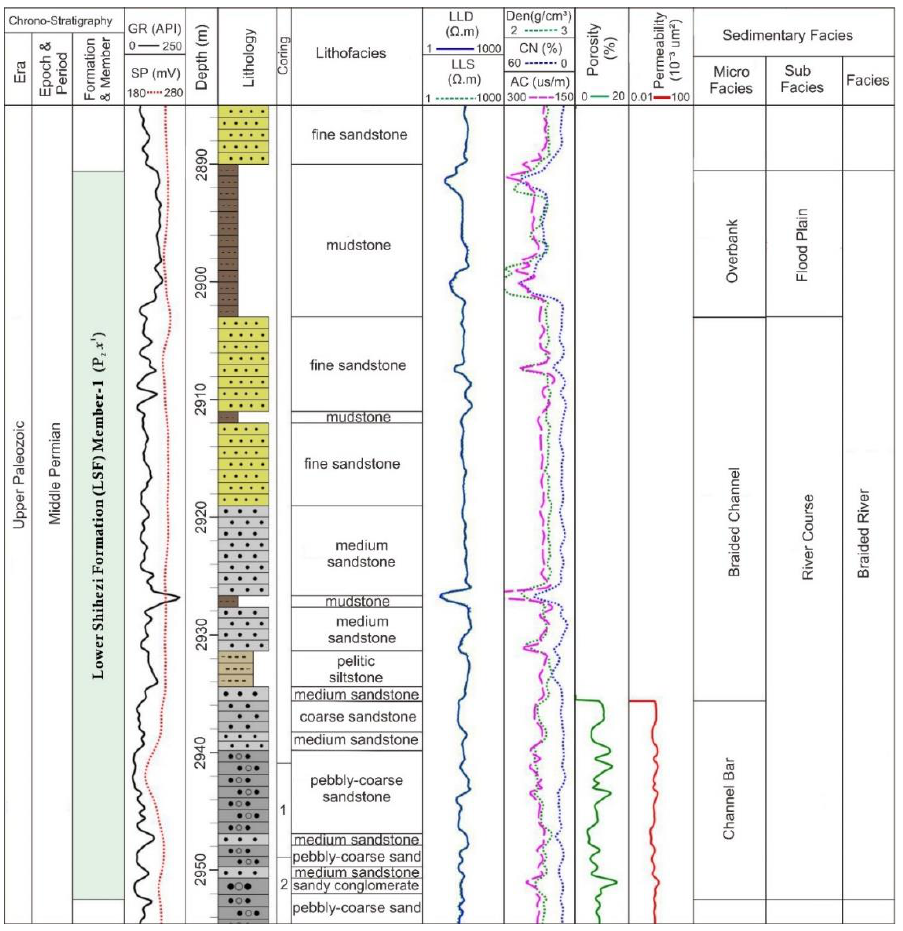
Figure 4. Sedimentary facies interpretation of well J72 through conventional well logs showing the porosity, permeability, and lithofacies for the member-1 (P 2 x 1 ) of the LSF.